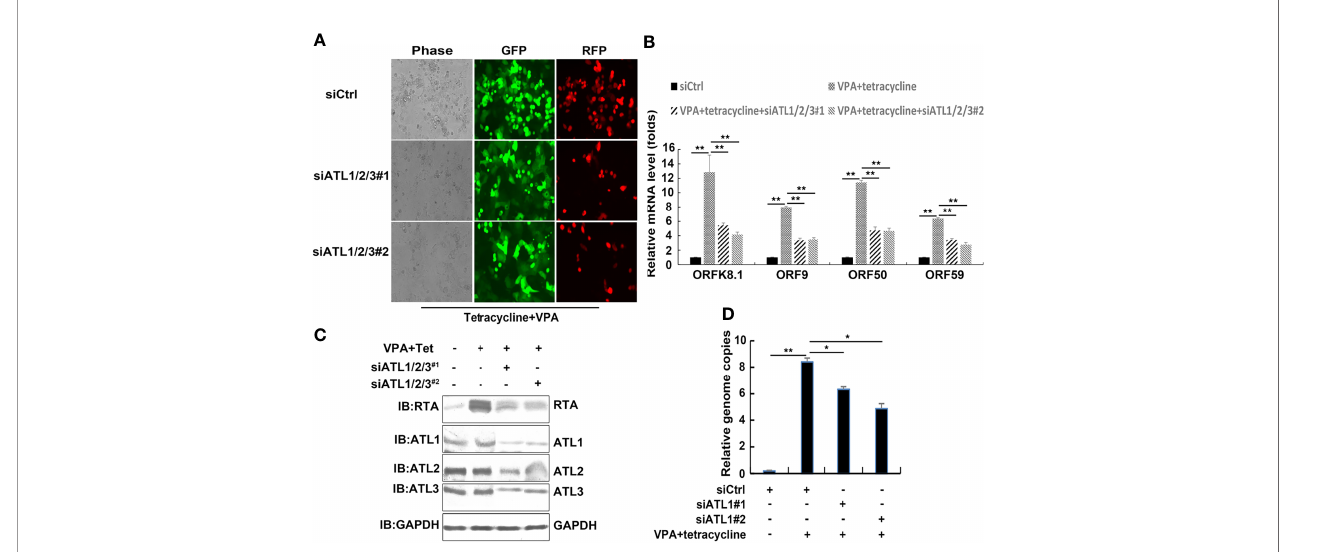
FIGURE 5 | Silencing of ATLs impairs VPA induced KSHV lytic reactivation and virus particle production in iSLK.rKSHV.219 cells. iSLK.rKSHV.219 cells were transfected with siCtrl, siATL1/2/3#1 or siATL1/2/3#2 respectively followed by treatment with tetracycline plus valproate (VPA) for 48 h to induce KSHV lytic reactivation. (A) The cells were photographed for GFP and RFP fl uorescence. (B) mRNA levels of KSHV lytic genes ORFK8.1 , ORF9 , ORF50 , and ORF59 were measured by RT-qPCR, with normalization to actin using the DD CT method. (C) Proteins were detected by western blot with indicated antibodies. (D) Viral DNA in the media was quanti fi ed using qPCR, with normalization to an added plasmid FAM105B using the DD CT method. Data are presented as means of three technical replicates (n = 3, group values are indicated by mean ± SEM; *p <0.05; **p <0.01).